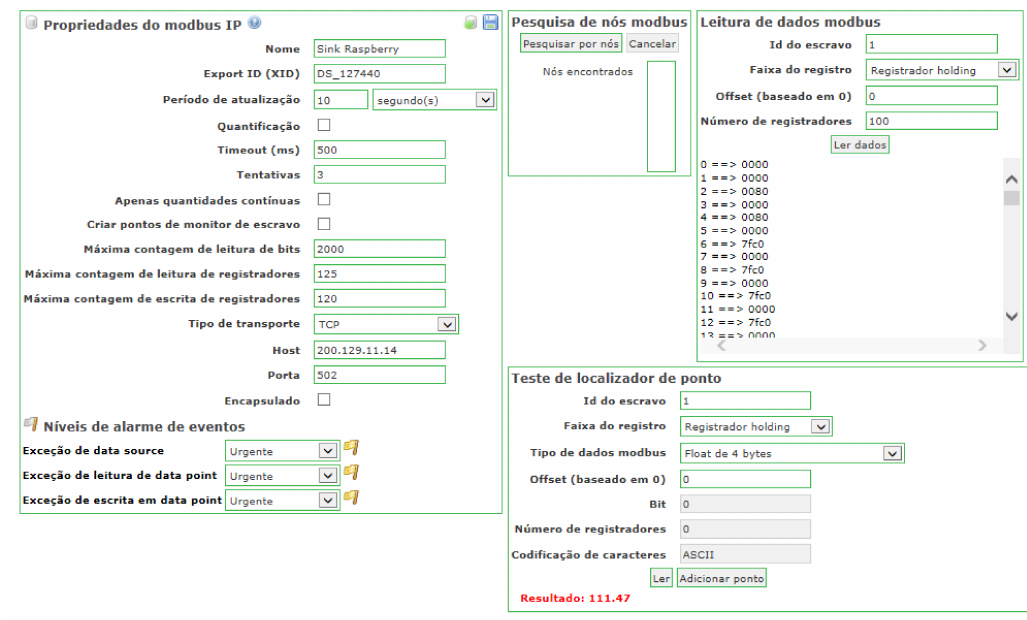
Figure 6. Screenshot of ScadaBR software using MODBUS protocol.